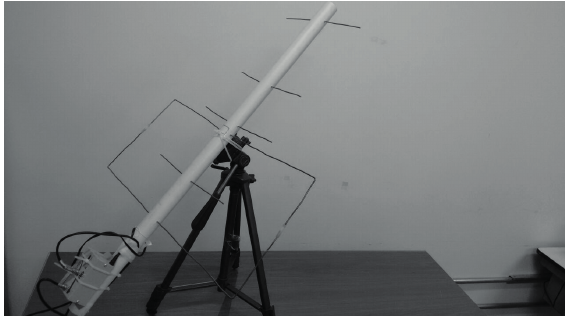
Figure 2 - Antenna VHF and UHF hand-assembled for receiving the satellite